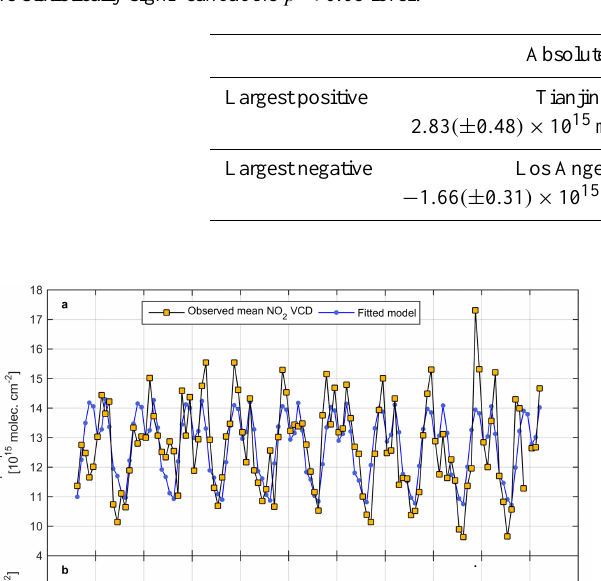
Table 2. Extreme values among the studied large urban agglomerations, both in terms of absolute and relative trends. All of the listed trends are statistically significant at the p < 0 . 05 level.